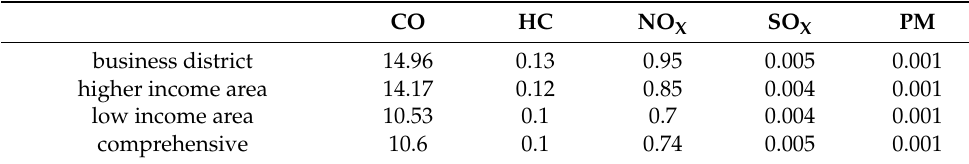
Table 4. Qingdao taxi pollutant emissions factor before correction